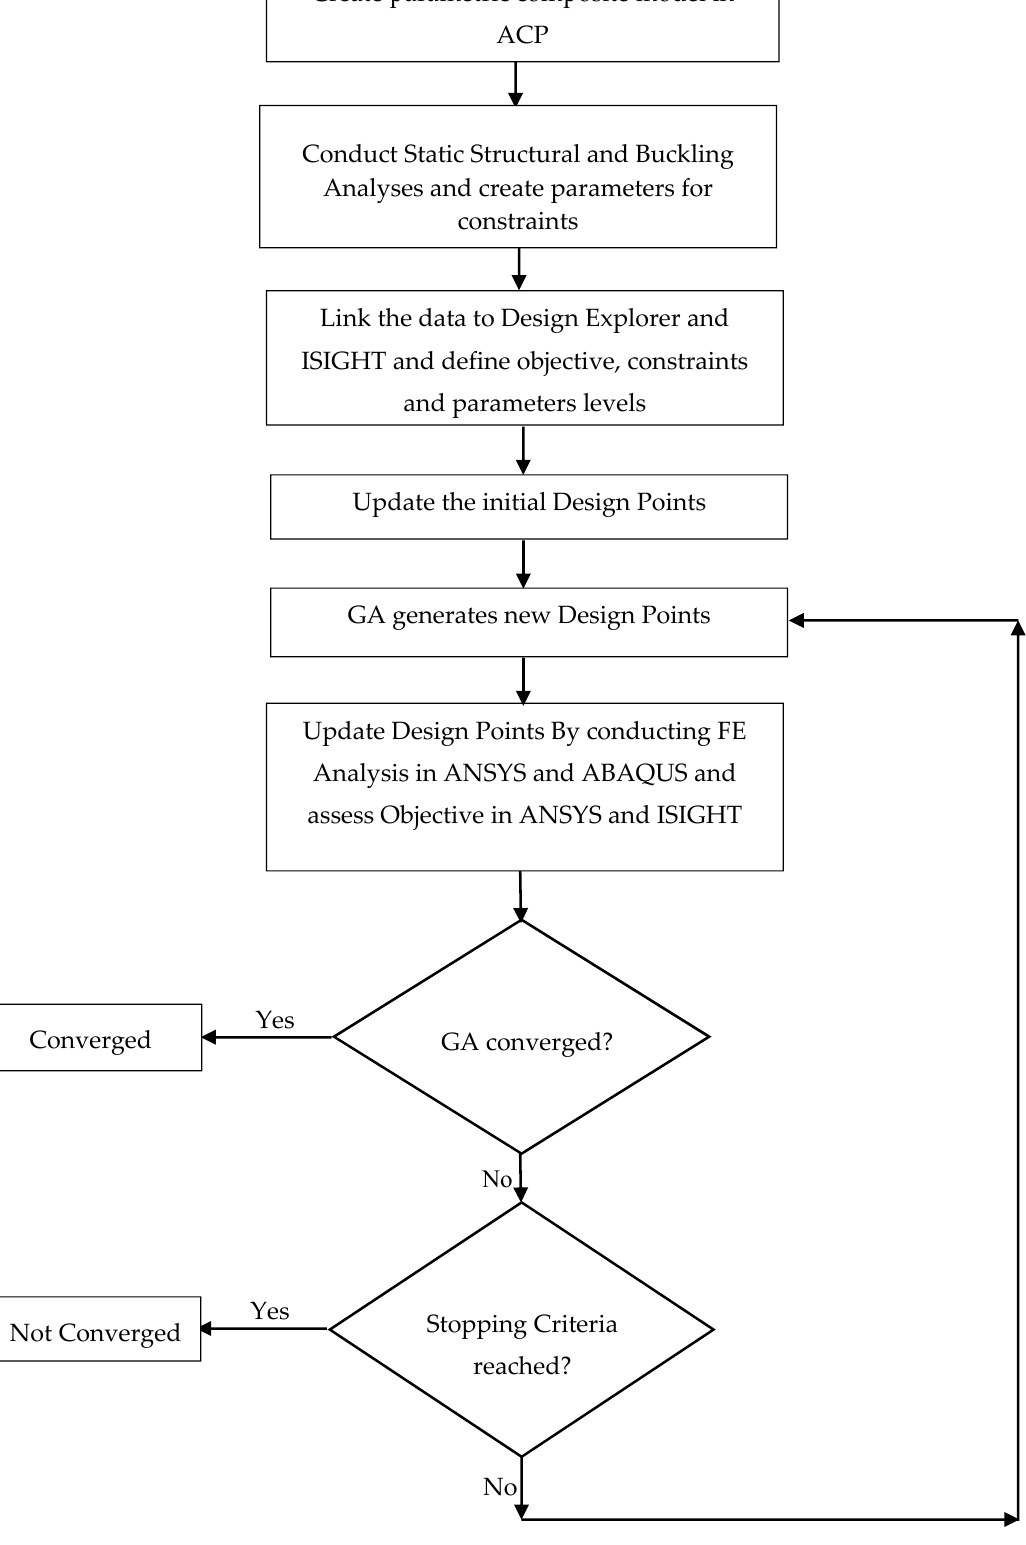
Figure 2. Optimization procedure flow chart [23].